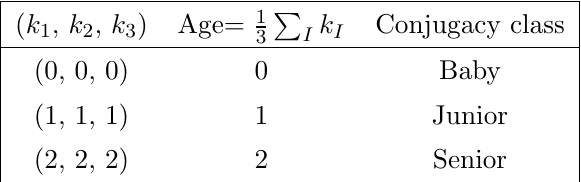
Table 2. The conjugacy classes of the orbifold model C 3 = Z 3 .